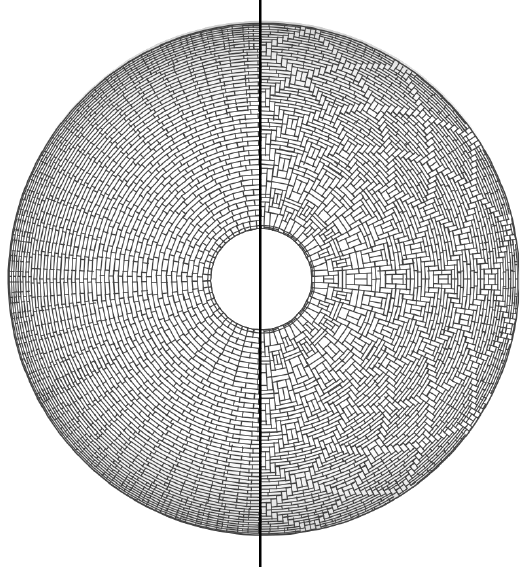
Figure 8: Left half dome: top view of common masonry pattern. Right half dome: top view of cross-herringbone masonry pattern